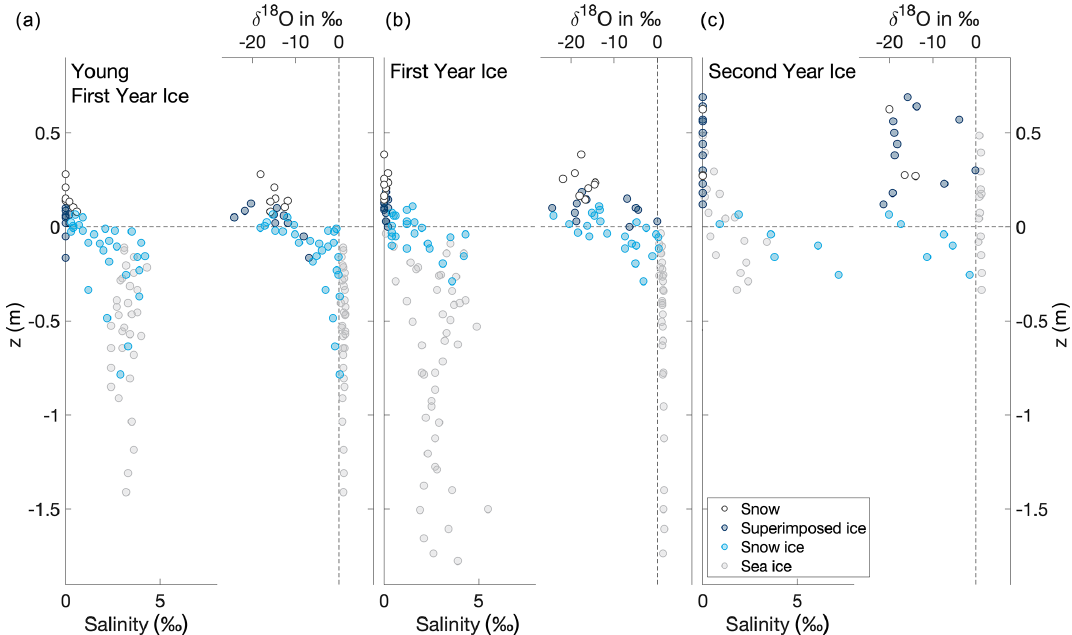
Figure 4. Vertical profiles of salinity and δ 18 O of all sampled ice cores from (a) young first-year ice, (b) first-year ice, and (c) second-year ice. Markers are plotted at the center position of the individual core segment, relative to the water level ( z = 0cm). Colored circles mark snow (filled white circles), superimposed ice (filled dark blue circles), snow ice (filled light blue circles), and sea ice (filled light grey